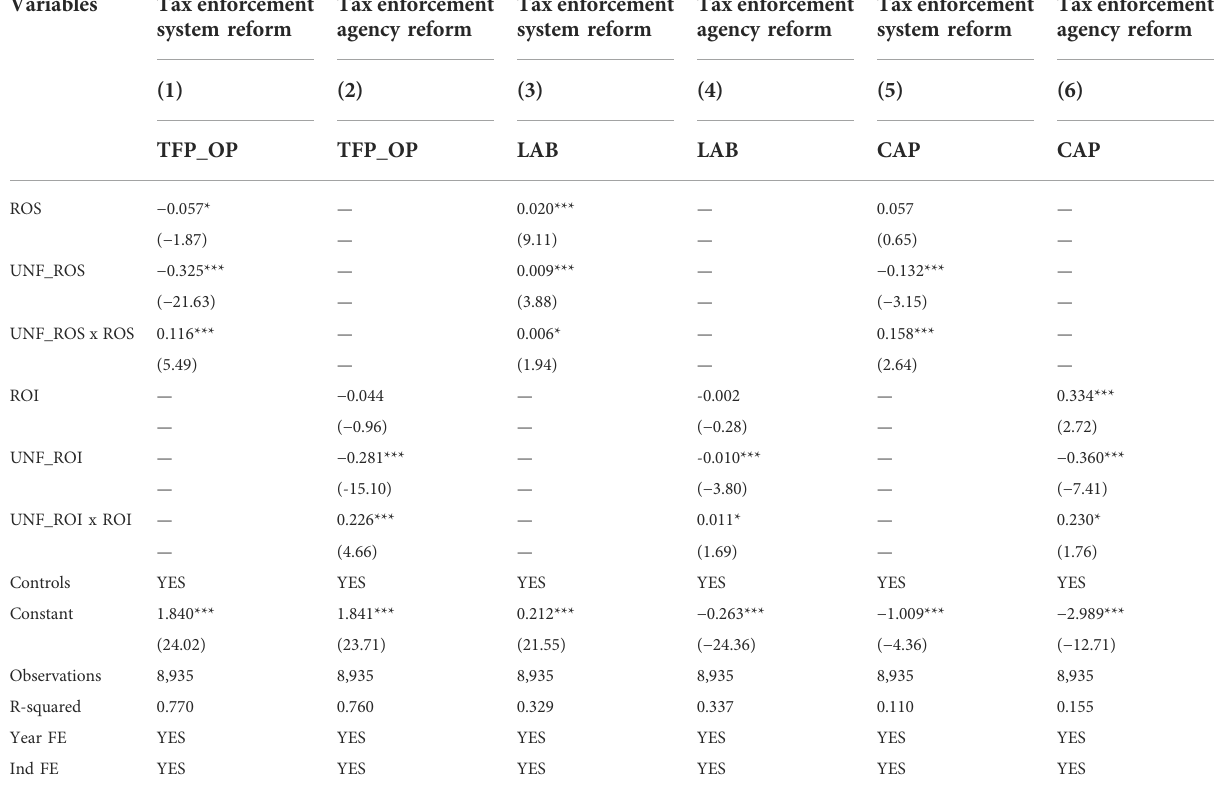
TABLE 8 Regression results substituting alternative measures of sustainable